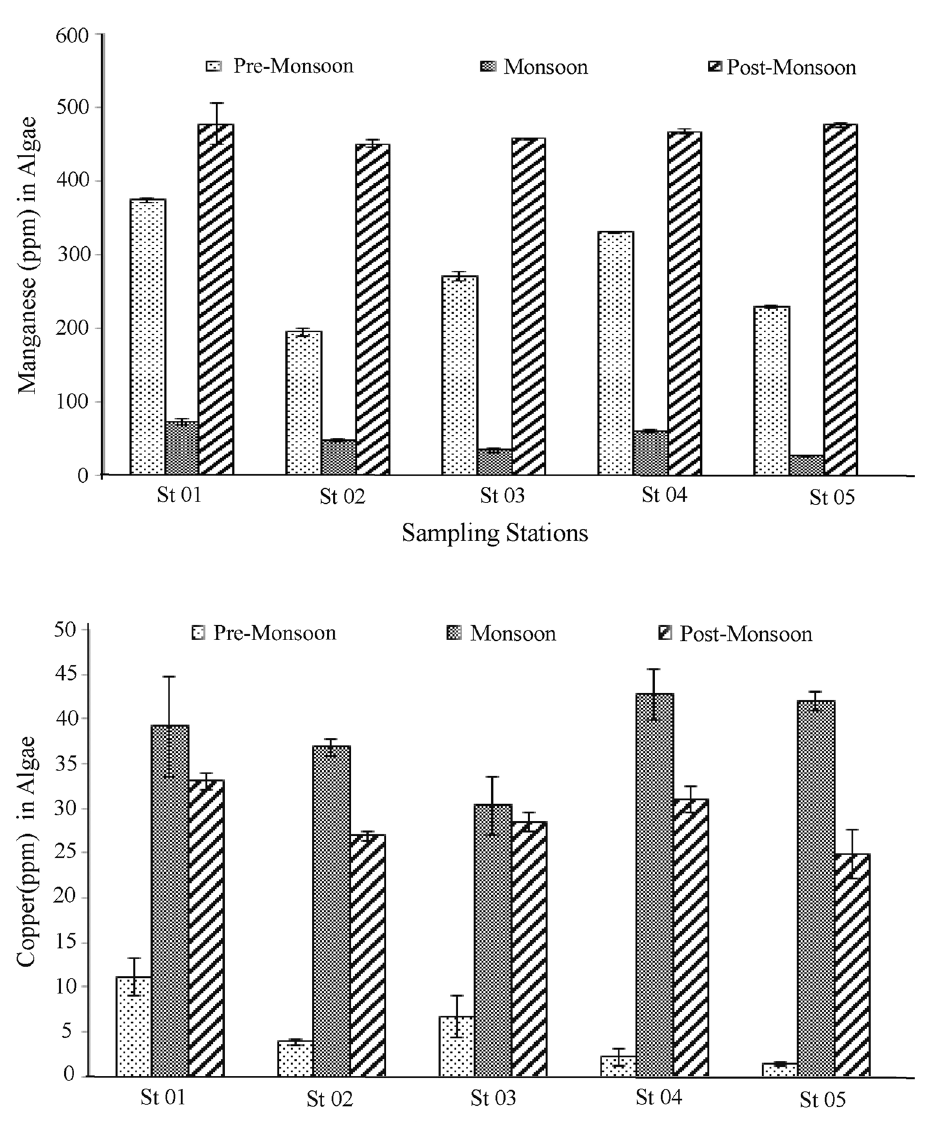
Fig. 11 Algal manganese concentration (± SD) variation at different seasons in different stations of Sundarban mangrove estuary